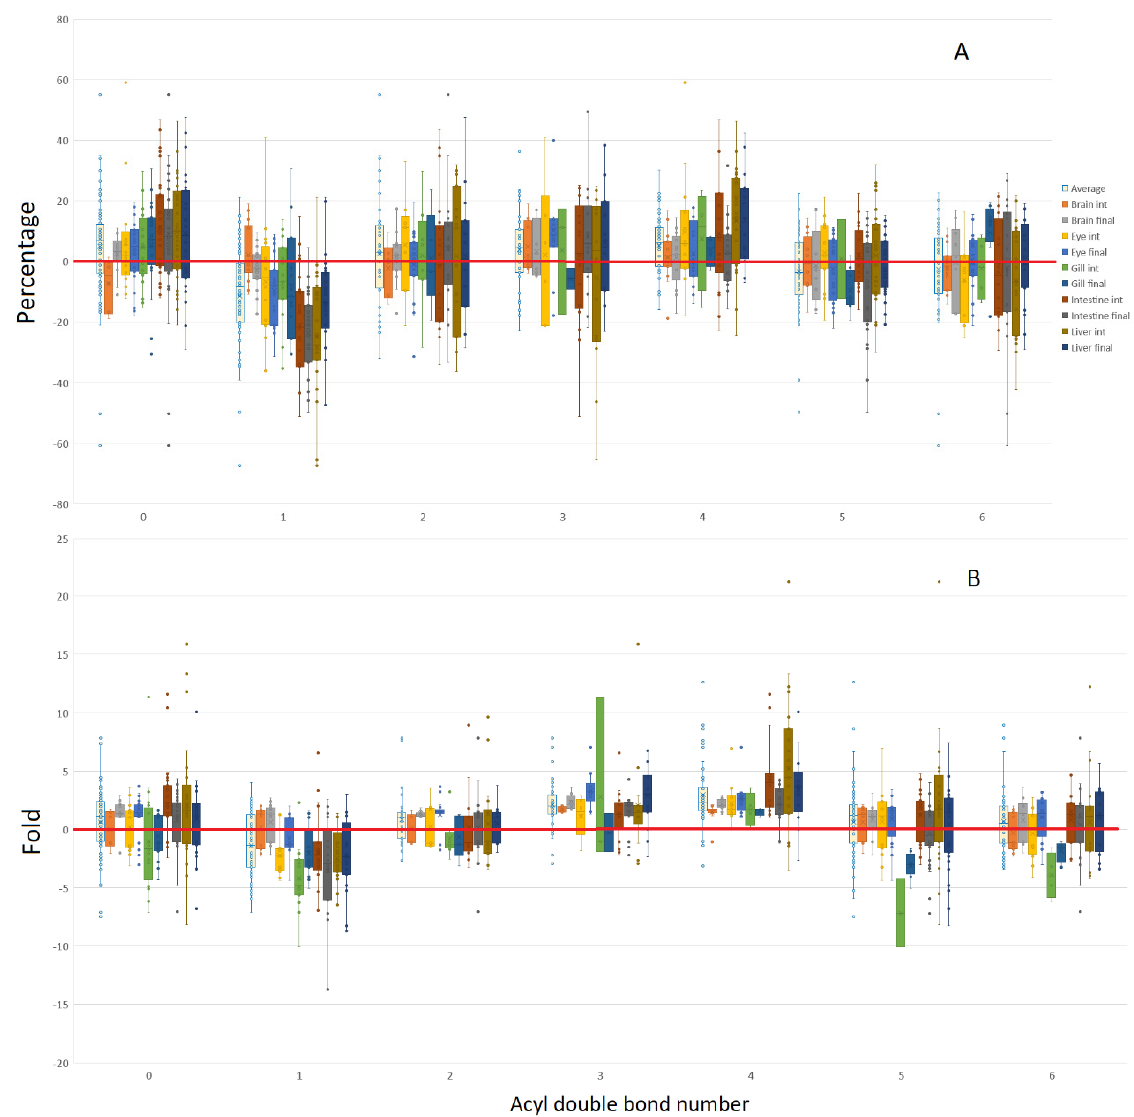
Figure 8. Acyl lipid double bond number bias toward the GM or control diets for combined PC and PE lipid pools, represented as a percentage ( A ) or fold data ( B ), with positive values GM biased, and negative values control biased. On average, acyl groups containing 1 double bond were increased by the control diet, whereas those containing 3–4 double bonds, tended to be increased by the GM diet.